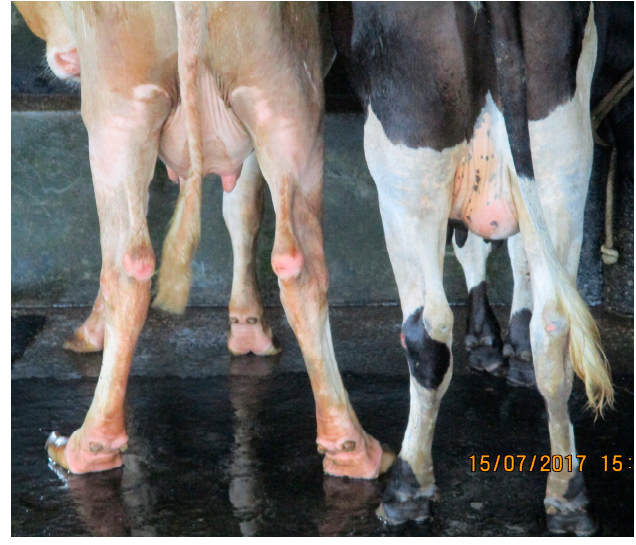
Figure 1. Stance of a non-lame cow ( right ), and a lame cow ( left ) displaying cow hock posture (Posterior view).